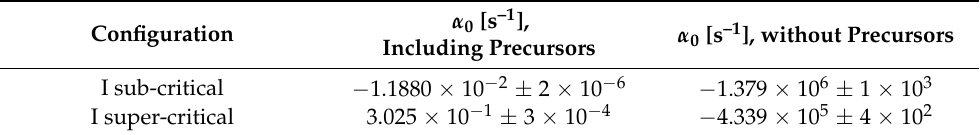
Table 5. Fundamental eigenvalues α 0 for Problem I.